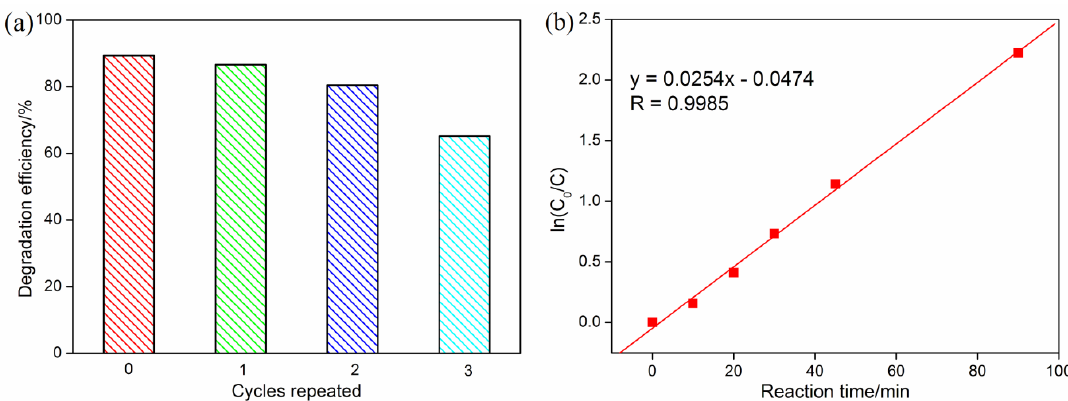
Figure 4. ( a ) The UV-Vis absorption spectra of methyl orange (MO) solution during the decomposition reaction under UV irradiation; ( b ) Degradation efficiencies of MO under UV light.